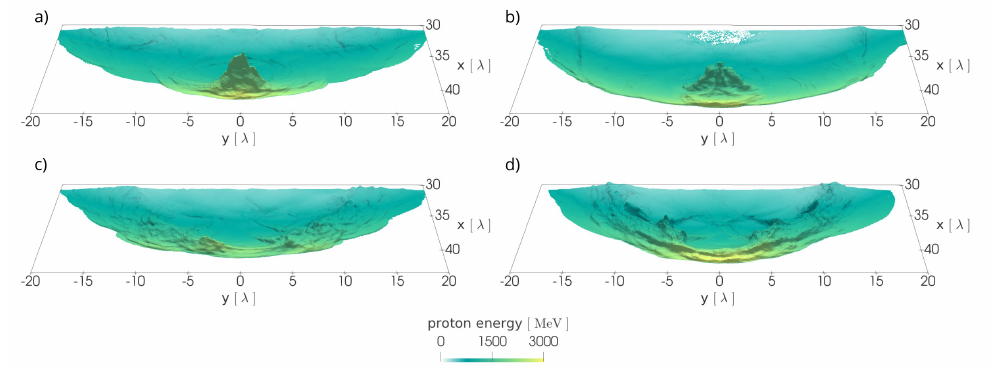
Figure 7. Spatial density distributions at time t = 47 T. The proton density is represented by the vertical height, and proton energy is represented by the blue to yellow scale. The simulated cases are: ( a ) HL, ( b ) LH, ( c ) HL–WO, ( d ) L2 (see parameters of all the targets in the text). Reprinted from [41], with permission from